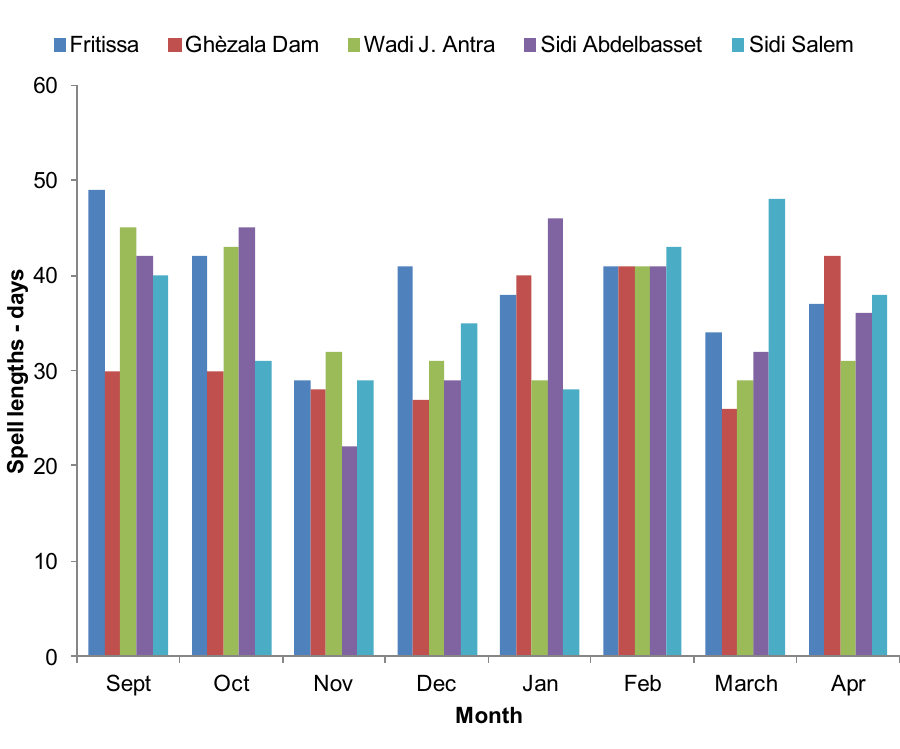
Fig. 5 Maximum monthly dry spell recorded at each station within the rainy